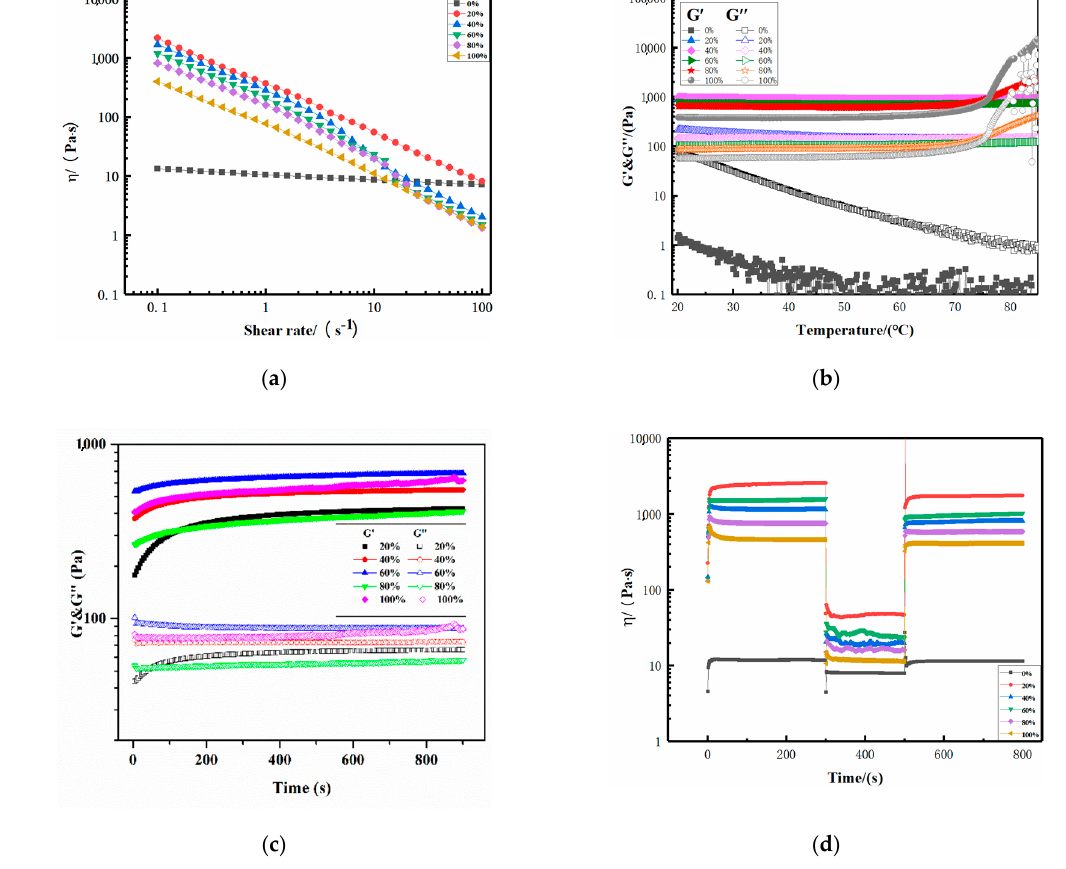
Figure 5. Flow measurement ( a ), temperature sweep ( b ), time sweep ( c ), and recovery tests ( d ) results of the xanthan gum-based eutectogels with di ff erent water contents and